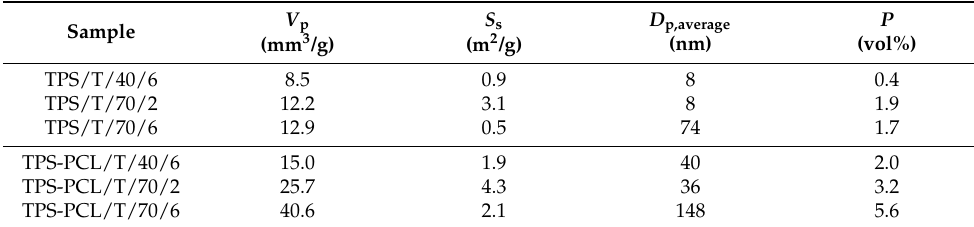
Table 2. Textural characteristics of the prepared TPS-based